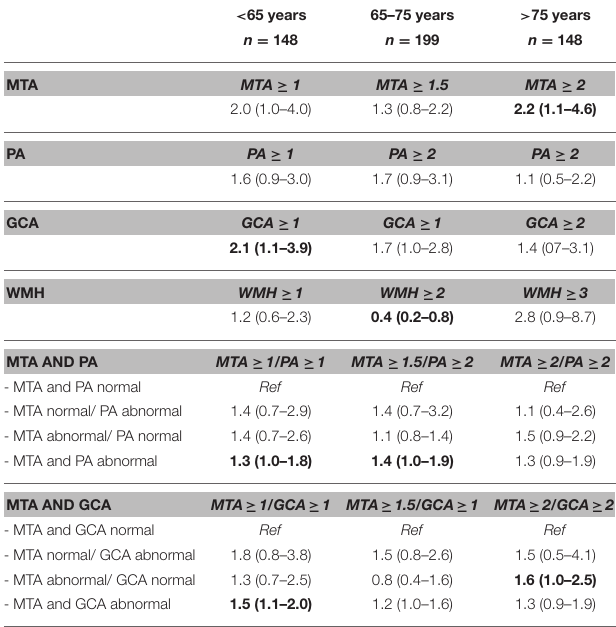
TABLE 7 | Cox proportional hazard models; influence of MTA, PA, GCA, TABLE 6 | Baseline visual ratings of MCI patients according to diagnosis and WMH and combination of MTA/PA and MTA/GCA on progression of at follow-up by age group. MCI to dementia due to AD in the three age Stable MCI at FU Progression to AD at FU